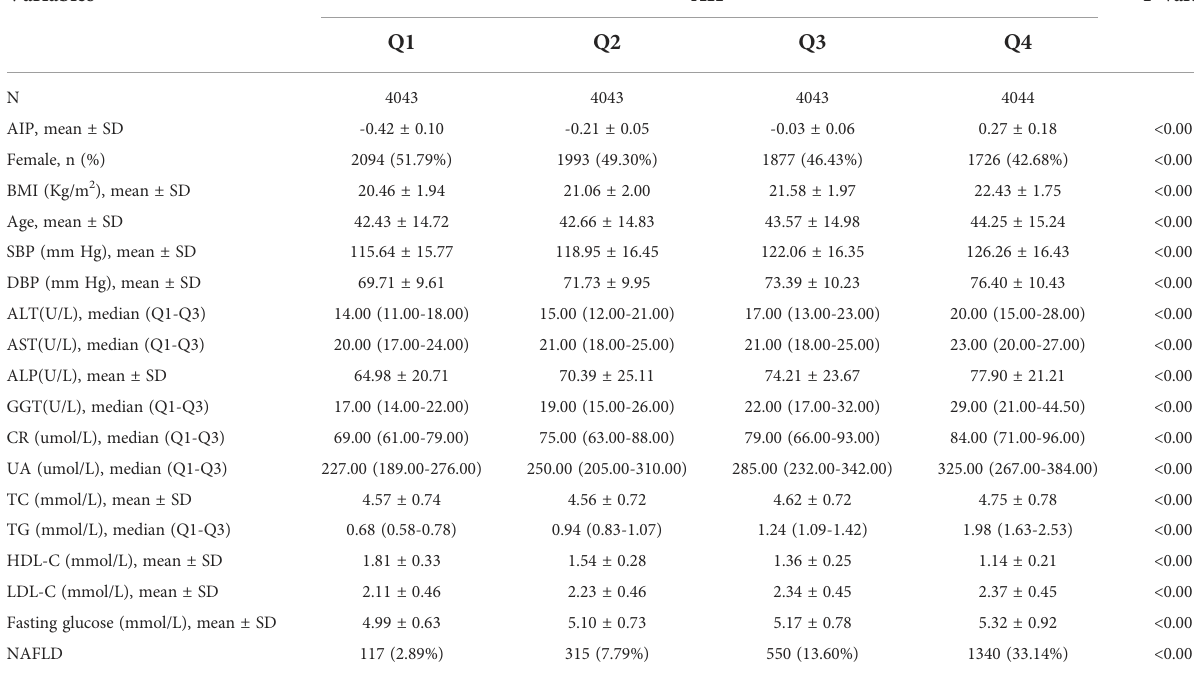
TABLE 1 Baseline characteristic of the participants included in the analysis according to AIP